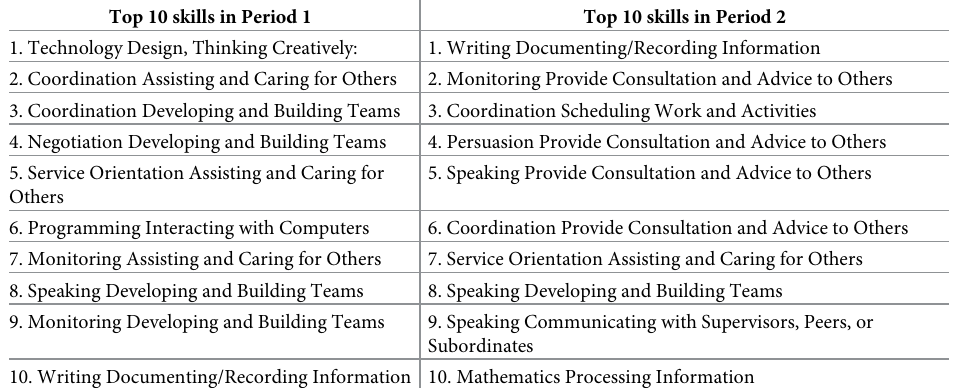
Table 6. Top 10 skills in Periods 1 and 2.